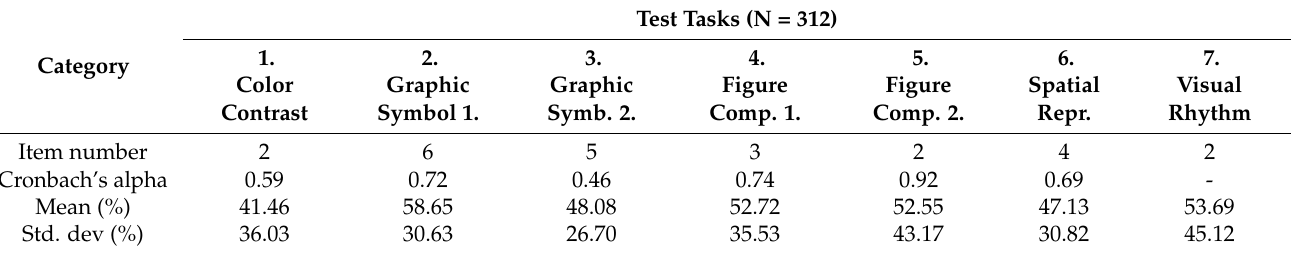
Table 8. Digital test of visual communication: “produce” domain. Results of the task-level analysis.